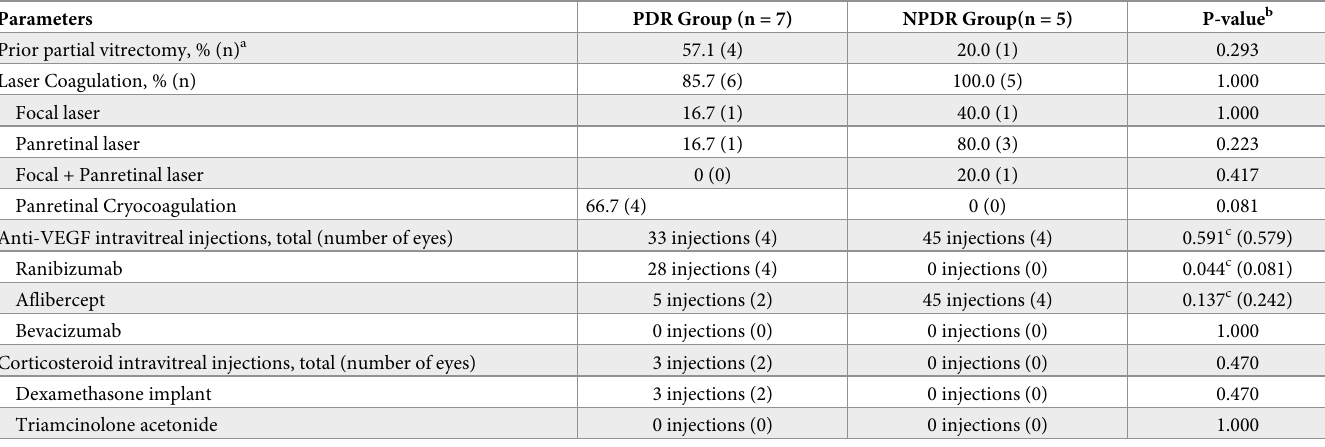
Table 2. Prior diabetic macular edema (DME) treatments at